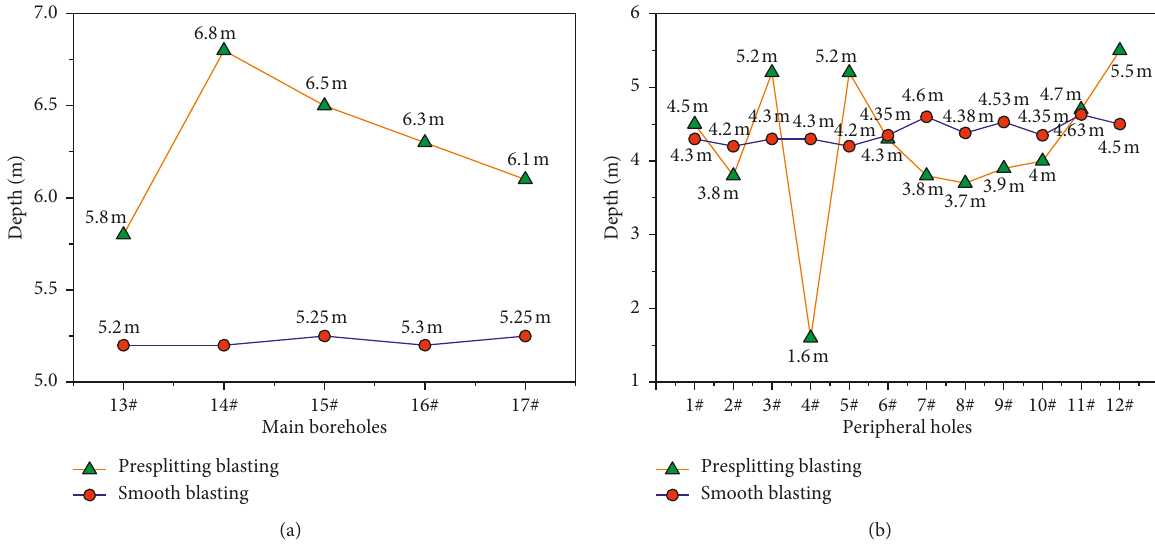
Figure 13: The depths of main and peripheral boreholes generated by two experiments. (a) The depths of five main boreholes. (b) The depths of peripheral